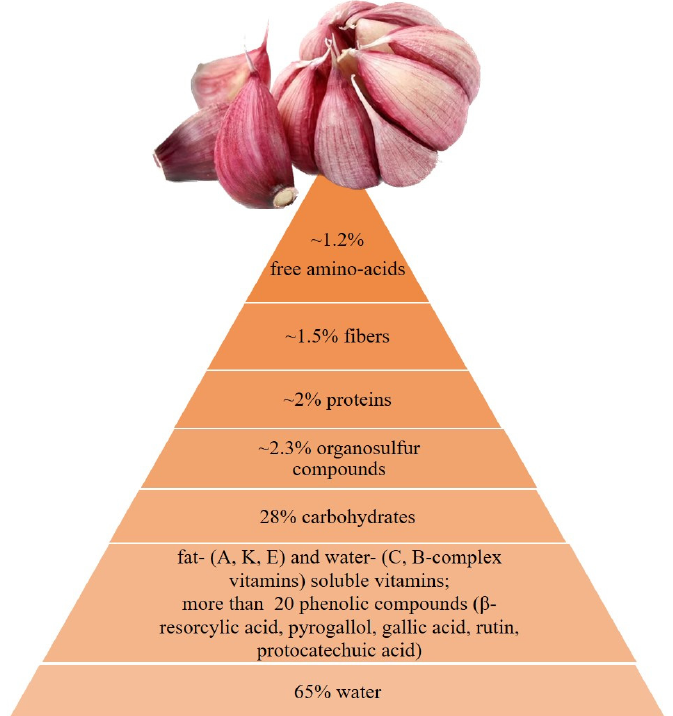
Figure 1. Fresh garlic composition and phenolic